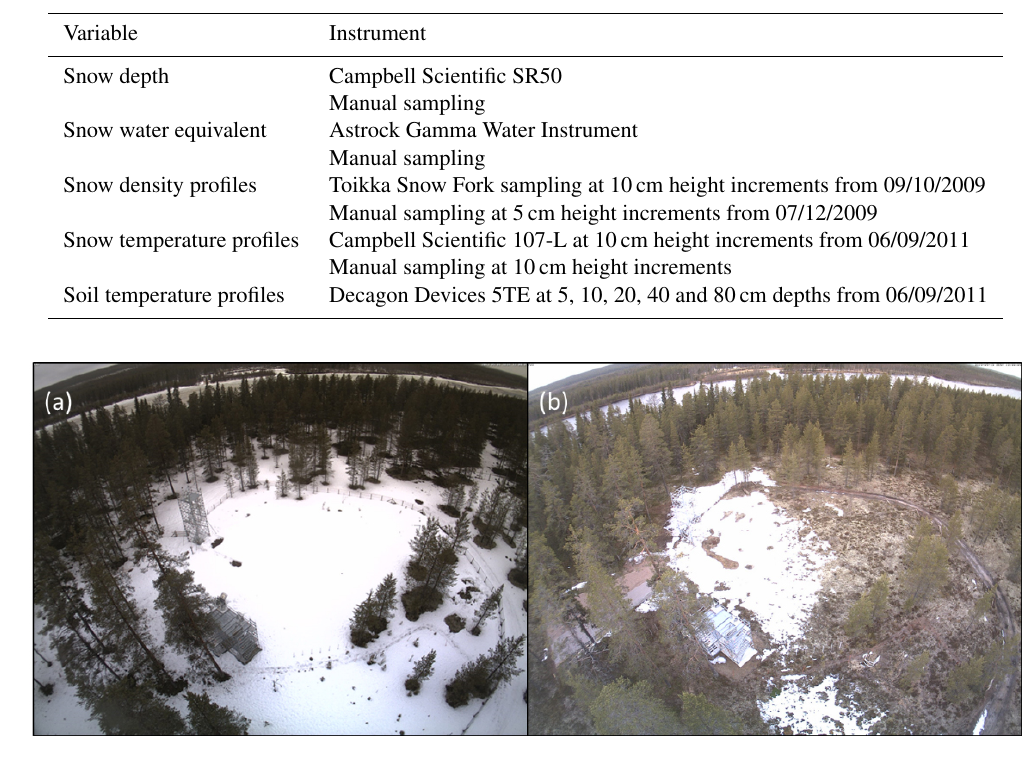
Table 3. Evaluation data from the IOA.